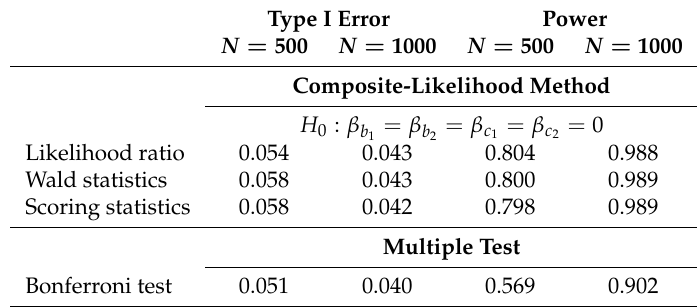
Table 2. Type 1 error rate and power under different sample sizes ( N = 500 and N =